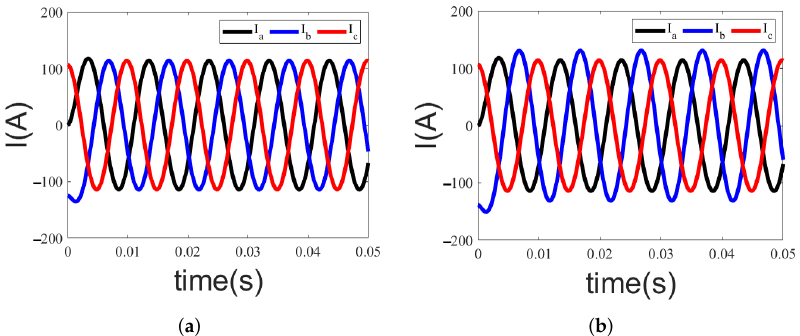
Figure 14. The current waveform when input voltage phase is imbalanced. ( a ) Input voltage phase is imbalanced when ITSC fault does not occur; ( b ) Input voltage phase is imbalanced and µ = 0.1 in B